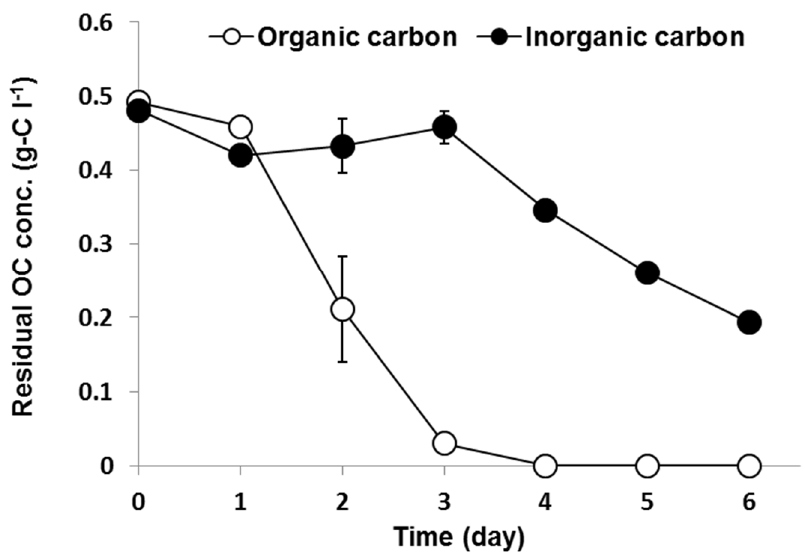
Figure 1. Variations in residual organic carbon (OC) and inorganic carbon concentrations over time in artificial wastewater under mixotrophic conditions. Artificial wastewater was prepared in a modified BG11 medium with NaHCO 3 0.5 g-C L − 1 and glucose 0.5 g-C L − 1 (error bars denote standard deviation ( n = 3)).